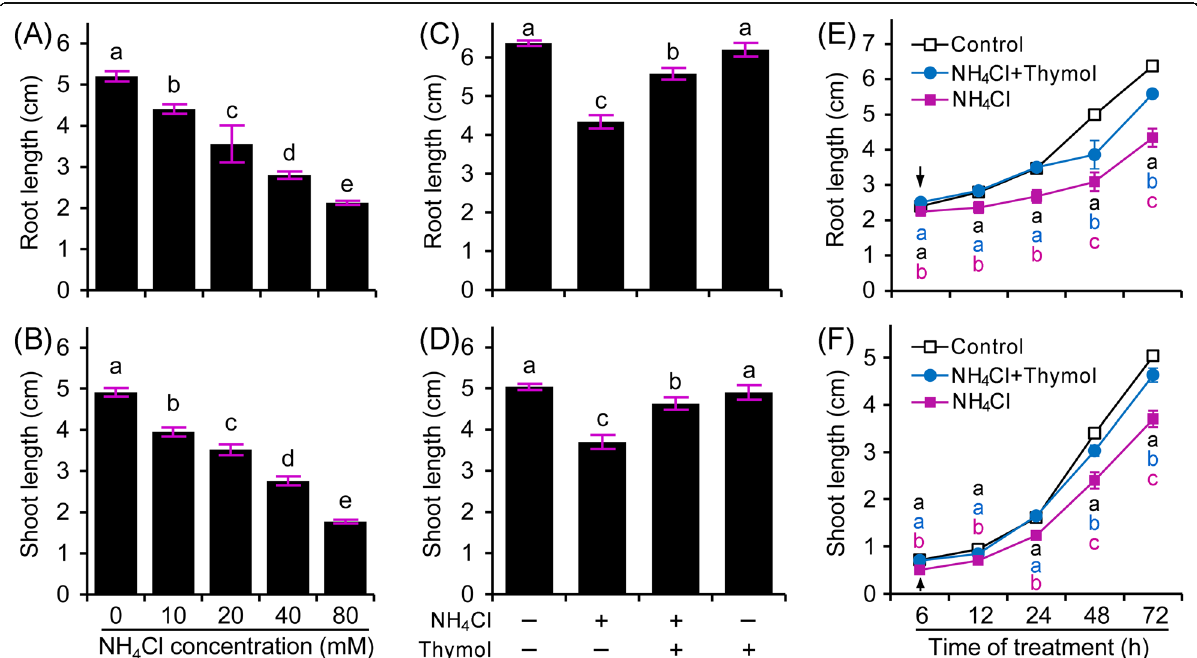
Fig. 1 Thymol attenuated ammonium-induced growth inhibition in rice seedlings. (A-B) Changes in the length of root and shoot after NH 4 Cl exposure for 72 h. (C-D) Changes in the length of root and shoot after NH 4 Cl (20 mM) exposure with or without thymol (20 μ M) for 72 h. (E-F) Time-dependent changes in root length and shoot length after NH 4 Cl (20 mM) exposure with or without thymol (20 μ M) up to 72 h. The black arrow in (E-F) indicates that the seedlings of NH 4 Cl + Thymol treatment begin to grow significantly longer that NH 4 Cl treatment. Different lowercase letters indicate that the mean values of ten replicates are significantly different among different treatments ( P < 0.05, ANOVA,